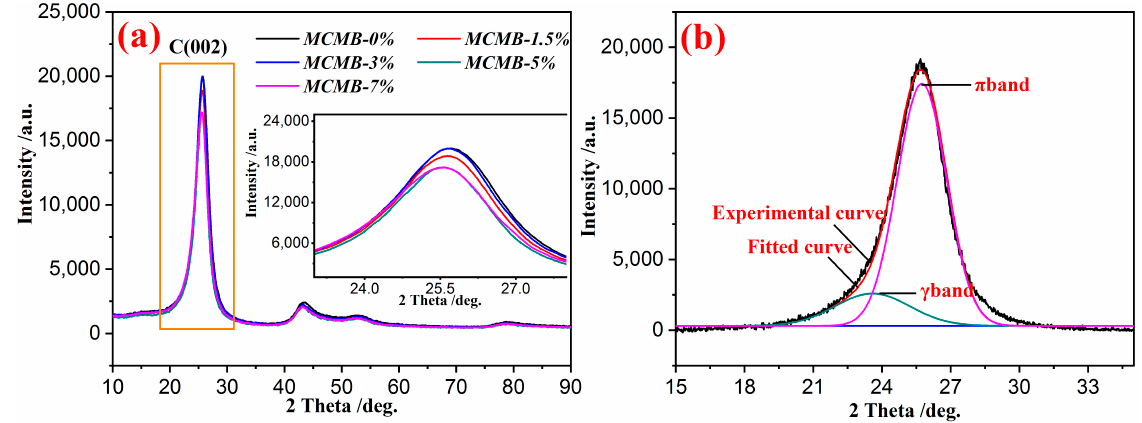
Figure 6. XRD graphs of MCMBs ( a ) and a curve-fitted graph of MCMB-3% ( b ).